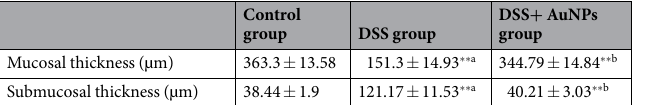
Table 2. Mucosal and submucosal thickness of different groups. Values are expressed as mean ± standard error of means (SEM) of n = 8 animals. a P compared with control group. b P compared with DSS group. ∗ Significant difference ( P < 0.05). ∗∗ Highly significant difference ( P < 0.001).